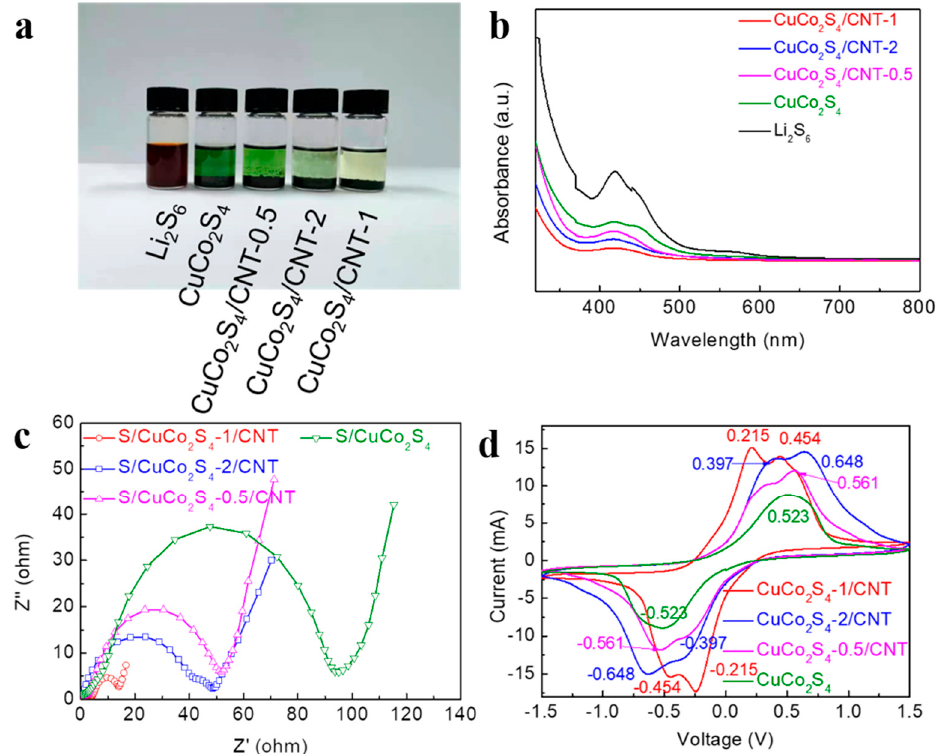
Figure 7. ( a ) Optical images and ( b ) UV-vis spectra after LiPSs adsorption by S/CuCo 2 S 4 -1/CNT, S/CuCo 2 S 4 -2/CNT, S/CuCo 2 S 4 -0.5/CNT and S/CuCo 2 S 4 . ( c ) EIS spectra and ( d ) CV curves at 6 mV s − 1 of symmetric cells with CuCo 2 S 4 -1/CNT, CuCo 2 S 4 -2/CNT, CuCo 2 S 4 -0.5/CNT and CuCo 2 S 4 electrodes.